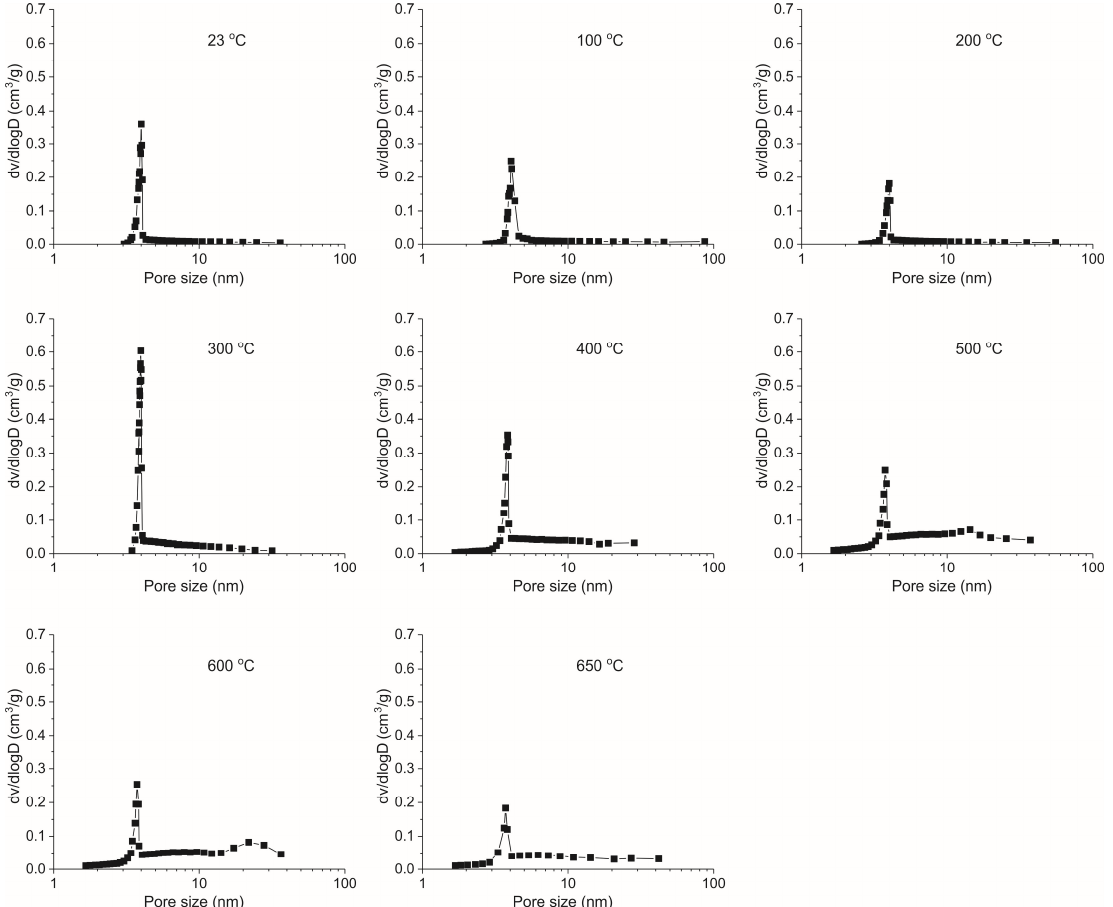
Figure 5. Pore size distribution (PSD) curve of LPNA at different pyrolysis temperatures.